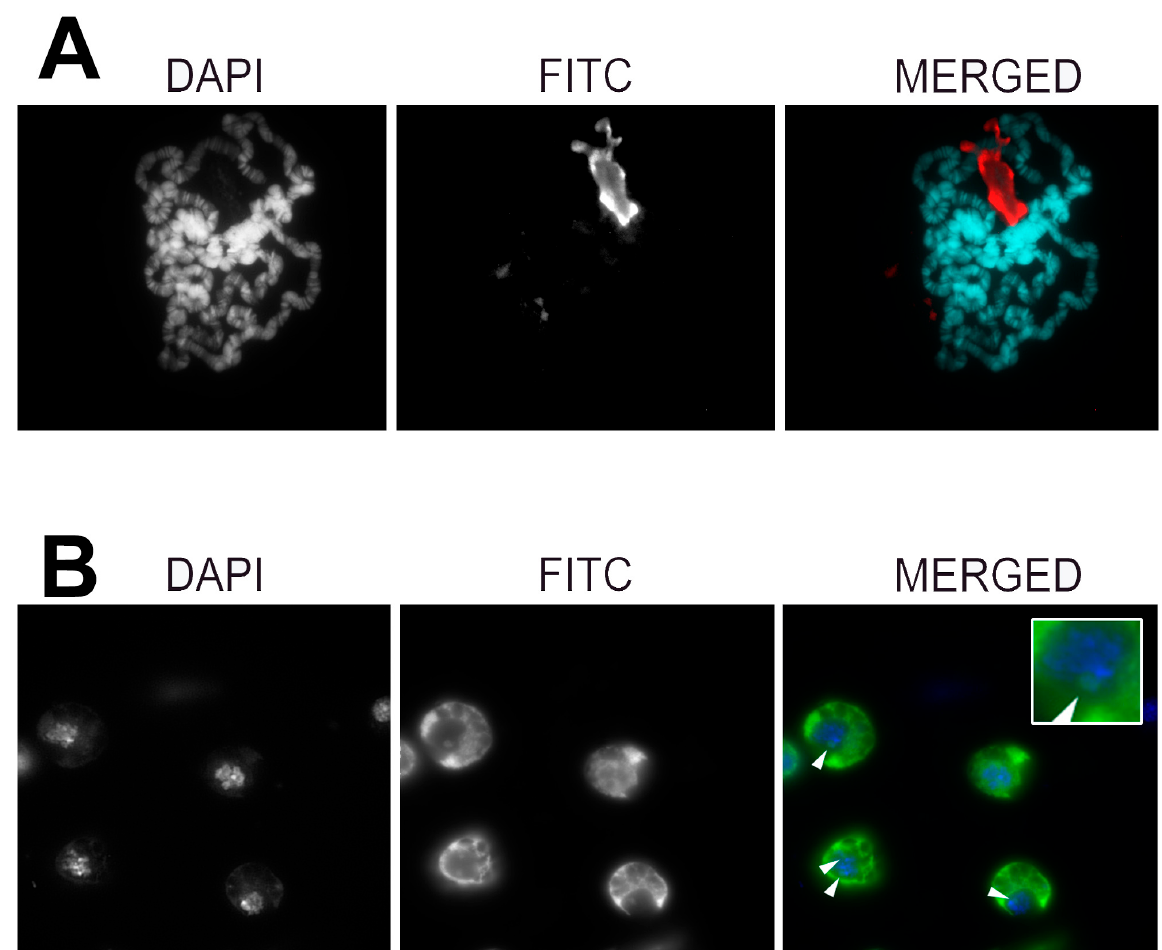
Figure 5. Pattern of subcellular immunolocalization of Rpl22 in D. melanogaster salivary gland nuclei ( A ) and in cultured S2R+ cells ( B ). White arrowheads point to nucleoli. A magnified detail of the nucleolar co-localization is reported in the inset. Additional details on the localization of Rpl22 to nucleoli are given in Figure S2.